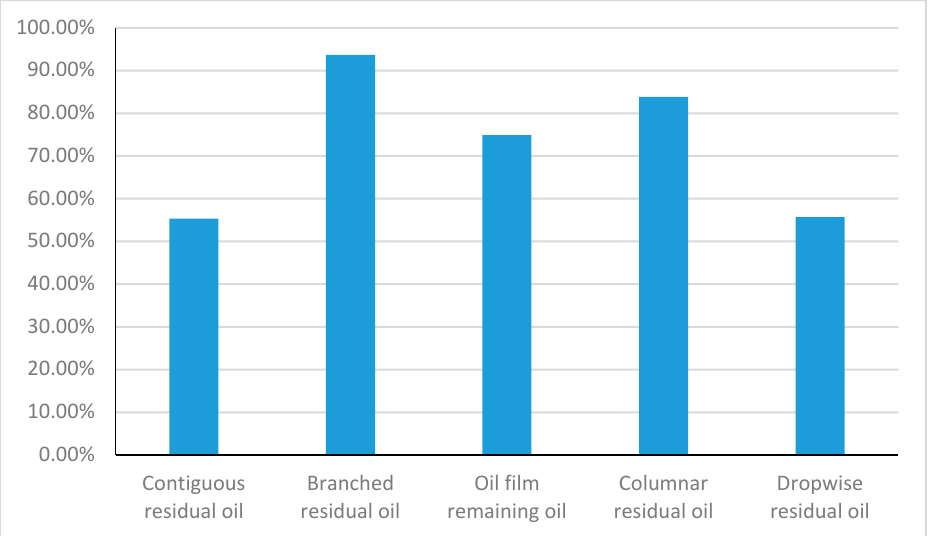
Figure 17. Percentage improvement of displacement efficiency of different types of remaining oil.